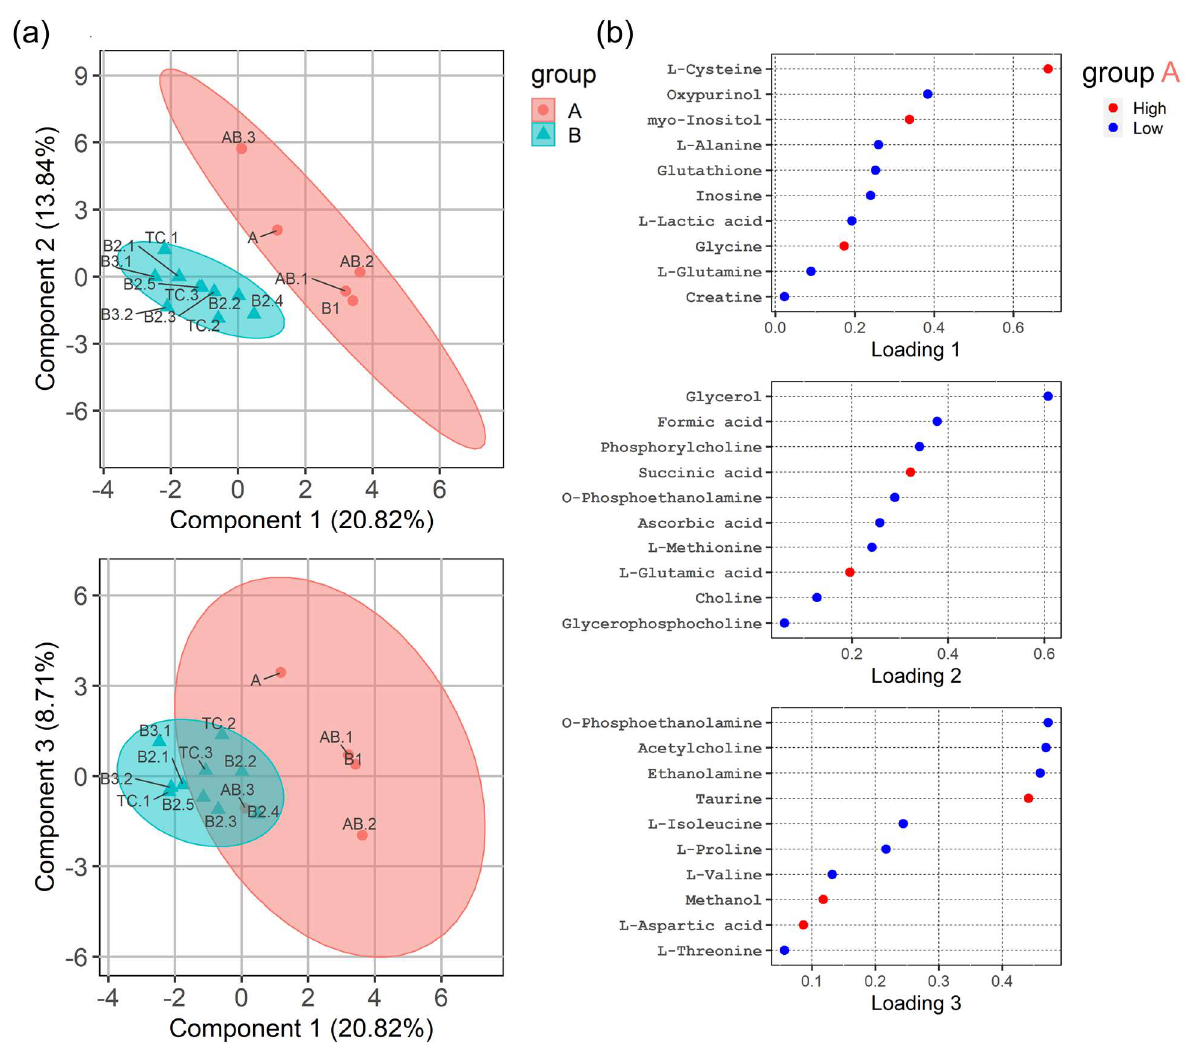
Figure 4. ( a ) sPLS-DA scores plot (3 components) showing clustering between indolent (group A) and aggressive (group B) thymic epithelial tumors (TETs). 95% confidence intervals are given in red (indolent group) and turquois (aggressive group). Top: Component 1 against component 2. Bottom: Component 1 against component 3. ( b ) sPLS-DA loadings plots for components 1 (top), 2 (middle) and 3 (bottom) showing upregulation and downregulations of metabolites for indolent TETs (upregulation is shown in red, downregulation in blue). The naming of the triangles and dots refers to the different tumor cases given in Table 1, for example B2.3 means the third B2 thymoma case from the top as listed in Table 1.